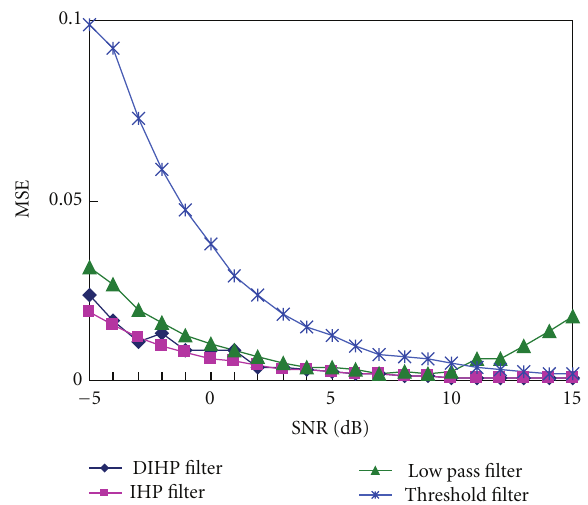
Figure 8: MSE obtained with di ff erent noise levels by proposed method, IHP filter, EEMD-based low pass filter, and EEMD-based thresholding